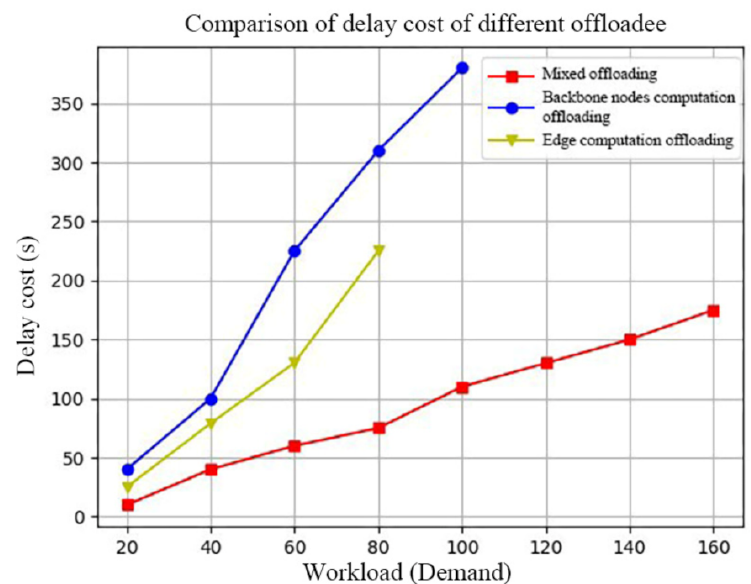
Figure 9. Comparison of delay costs of different offloading sites. Blue indicates that all tasks are offloaded to the backbone nodes of the network, yellow indicates that all tasks are offloaded to the edge nodes of the network, and red indicates the mixed offloading mode proposed in this paper, where some tasks are offloaded to the backbone nodes and the others are offloaded to the edge nodes. Compare the delay cost of the mixed computation offloading under a certain work request volume with that of the mode in which a particular offloading sites are selected